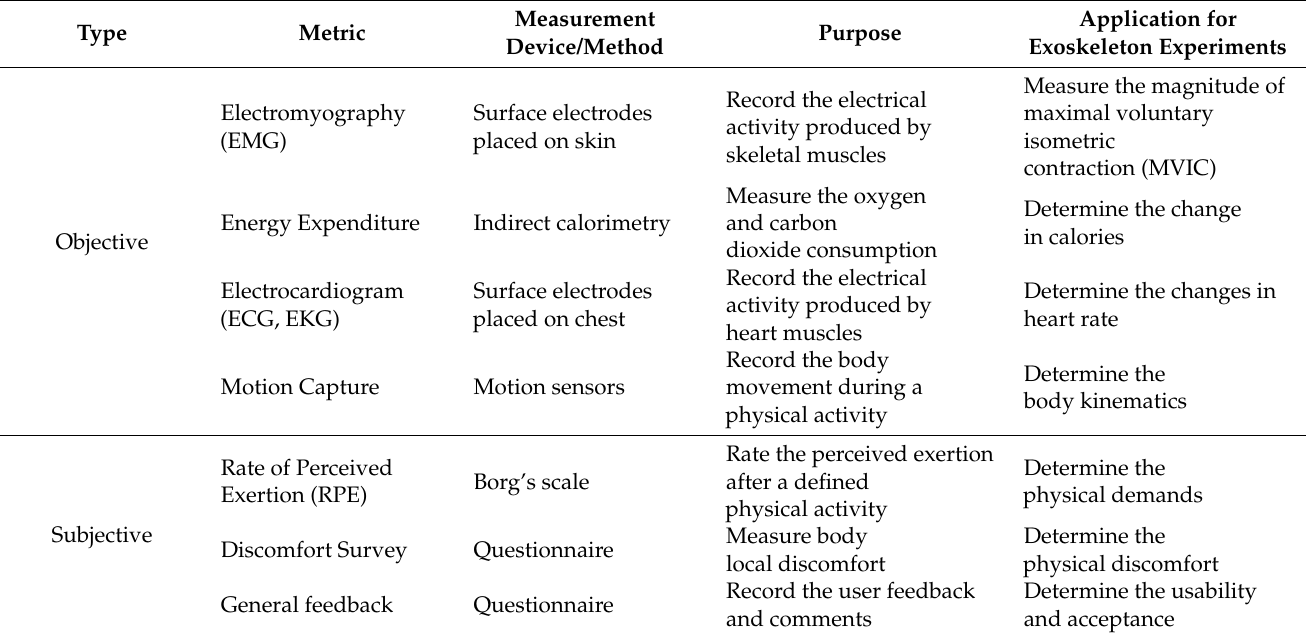
Table 5. Most common evaluation metrics adopted in evaluating